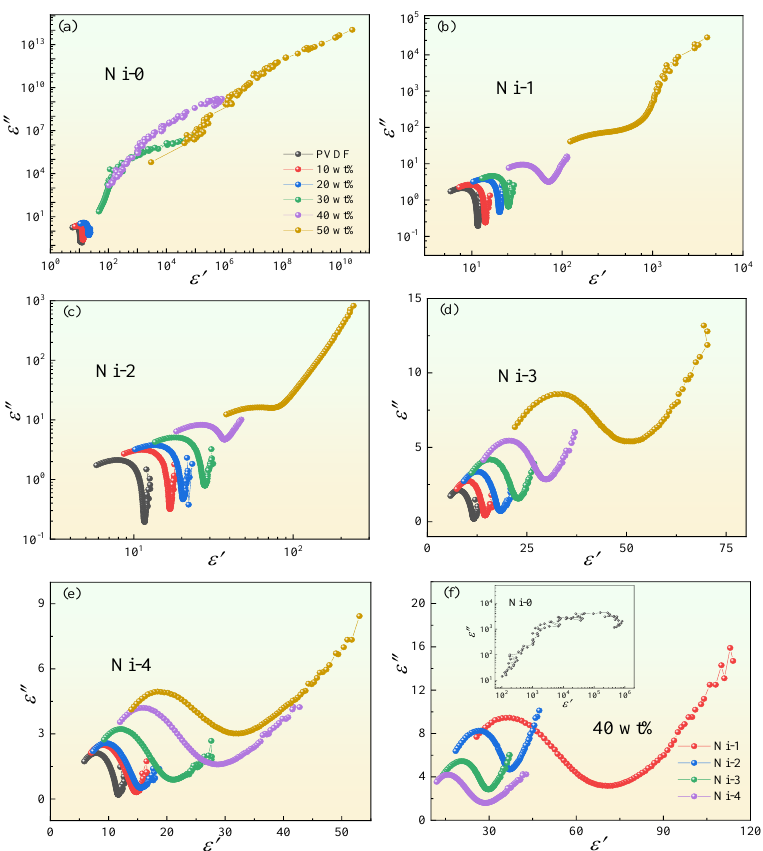
Figure 9. Cole–Cole curves of ε (cid:48)(cid:48) vs. ε (cid:48) for composites containing Ni–0~Ni–4 particles ( a – e ) containing different filler concentrations, and ( f ) ε (cid:48)(cid:48) vs. ε (cid:48) for PVDF including diverse fillers at 40 wt%. The insert is for the pristine